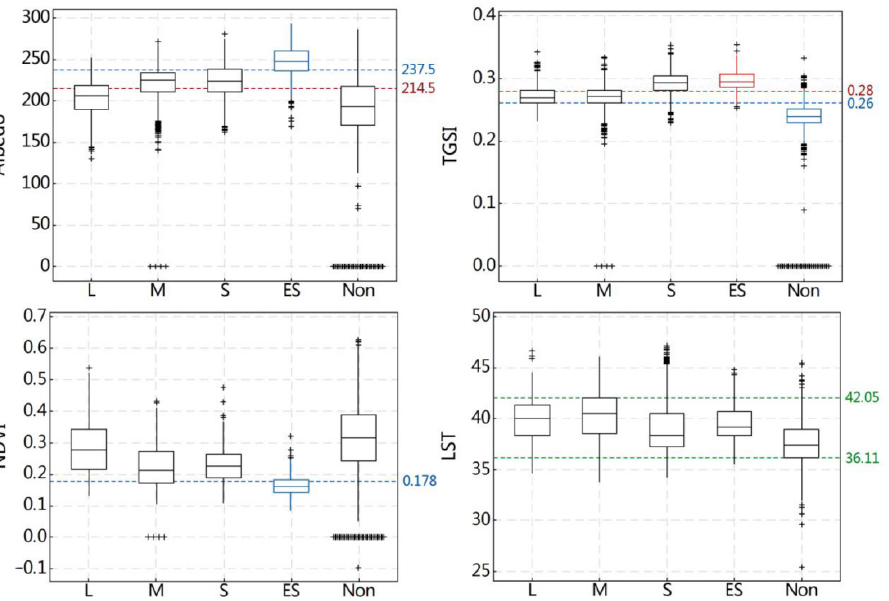
Figure 9. Threshold interval of monitoring indicators across different levels of desertification. In this study, 6000 pixels of monitoring indicators were randomly selected for box chart statistics from different desertified land. L—light desertification, M—moderate desertification, S —severe deserti- fication, ES—extremely severe desertification, Non—non-desertification.